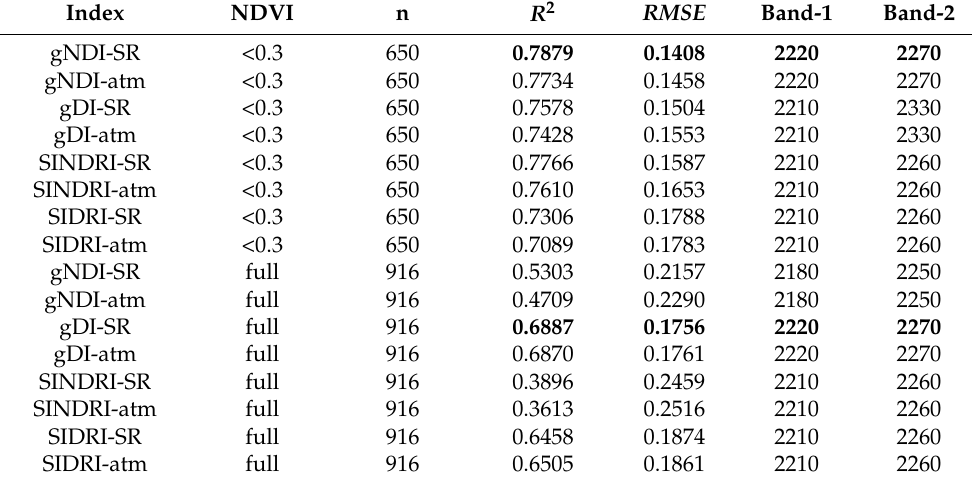
Table 1. 10 nm BARC dataset f R estimation performance comparison with the two-band wavelength shift analysis. The highest R 2 values for NDVI < 0.3 (upper rows; n = 650) and full-NDVI (lower rows; n = 916) have been bolded. The lowest RMSE for NDVI < 0.3 and full-NDVI have been bolded. Band-1 and Band-2 denote the wavelengths with the highest f R estimation performance for both R 2 and RMSE . For example, for gNDI, 2220 and 2270 nm exhibited the highest R 2 values, and these same wavelengths exhibited the lowest RMSE